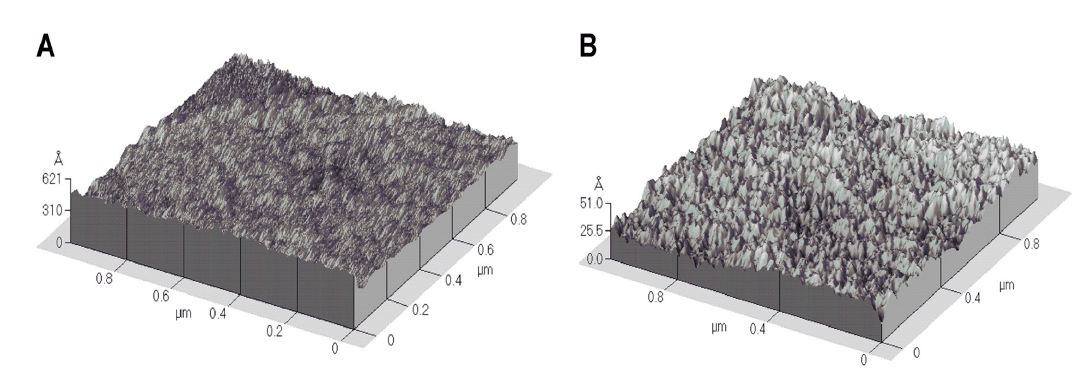
and B. S2-(PDMS) casted from a THF solution on a smooth glass 3 3